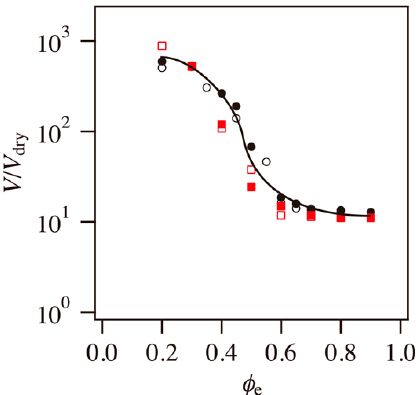
Figure 2. The degree of swelling V / V dry of the carboxylated SR gels with cross-linking times of 1.45 h (circle) and 2 h (square) as a function of ethanol volume fraction, φ e . Filled and open symbols denote shrinking and swelling processes, respectively. The solid line is an eye guide.